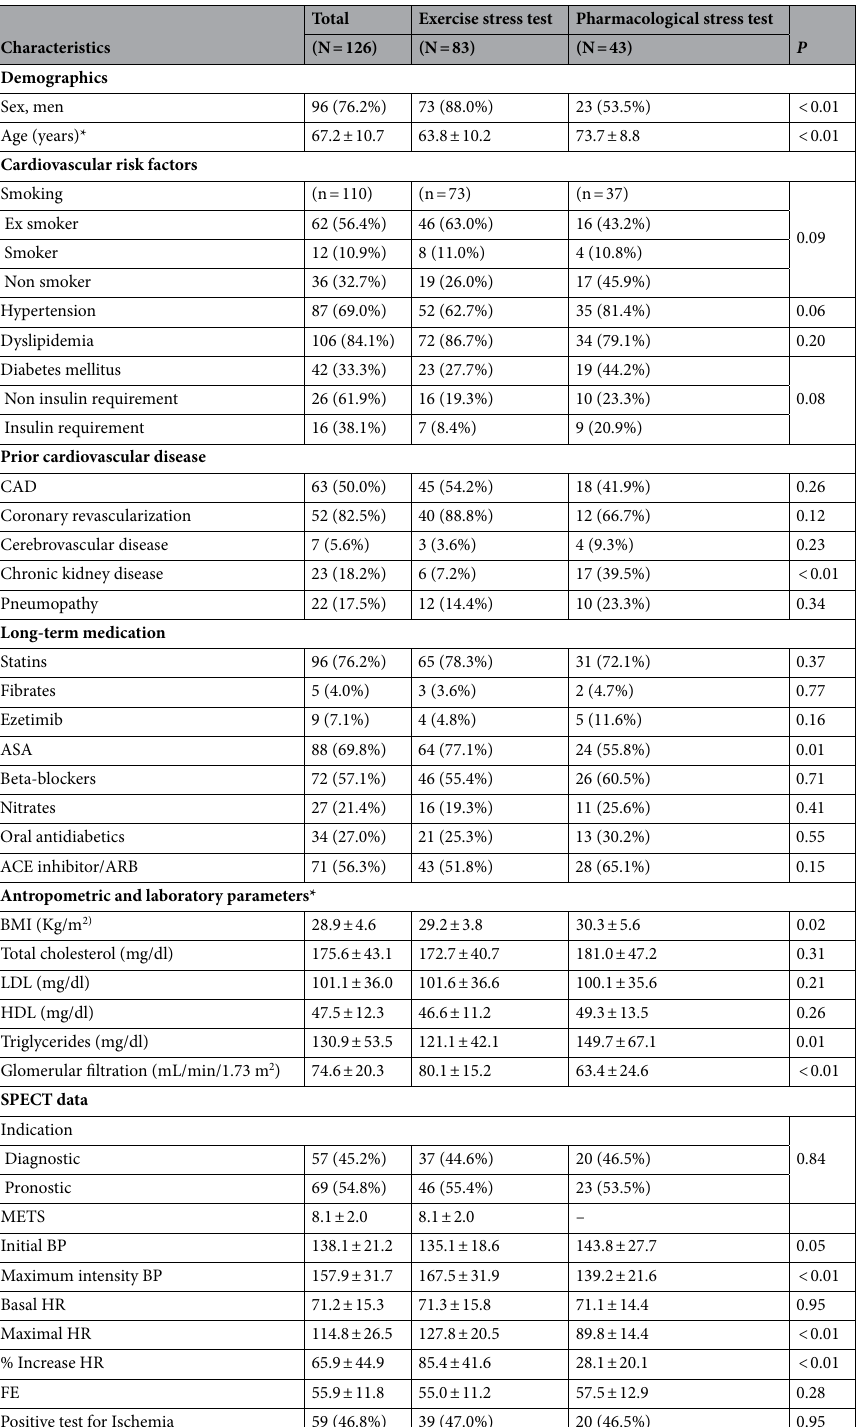
Table 1. Epidemiologic and demographic characteristics of the patients included in the study. *Mean ±